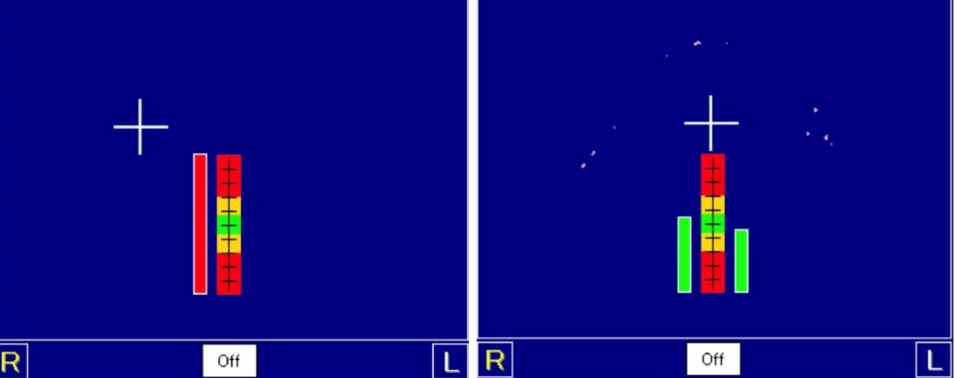
Figure 5. Pressure-sensitive sheet showing the occlusal contact points at the maximal cuspal position . The left image shows the contact point before the adjustment. The right image shows the increase in the contact points after selective grinding.